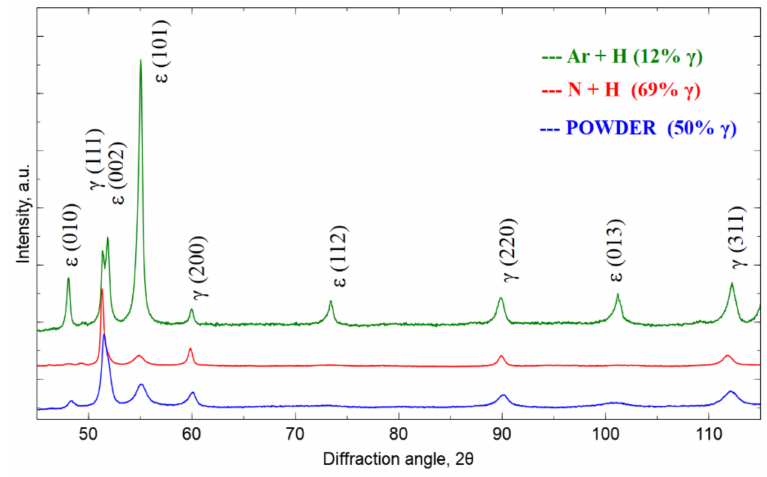
Figure 3. X-ray diffraction pattern for powder and materials sintered at 1350 ◦ C.